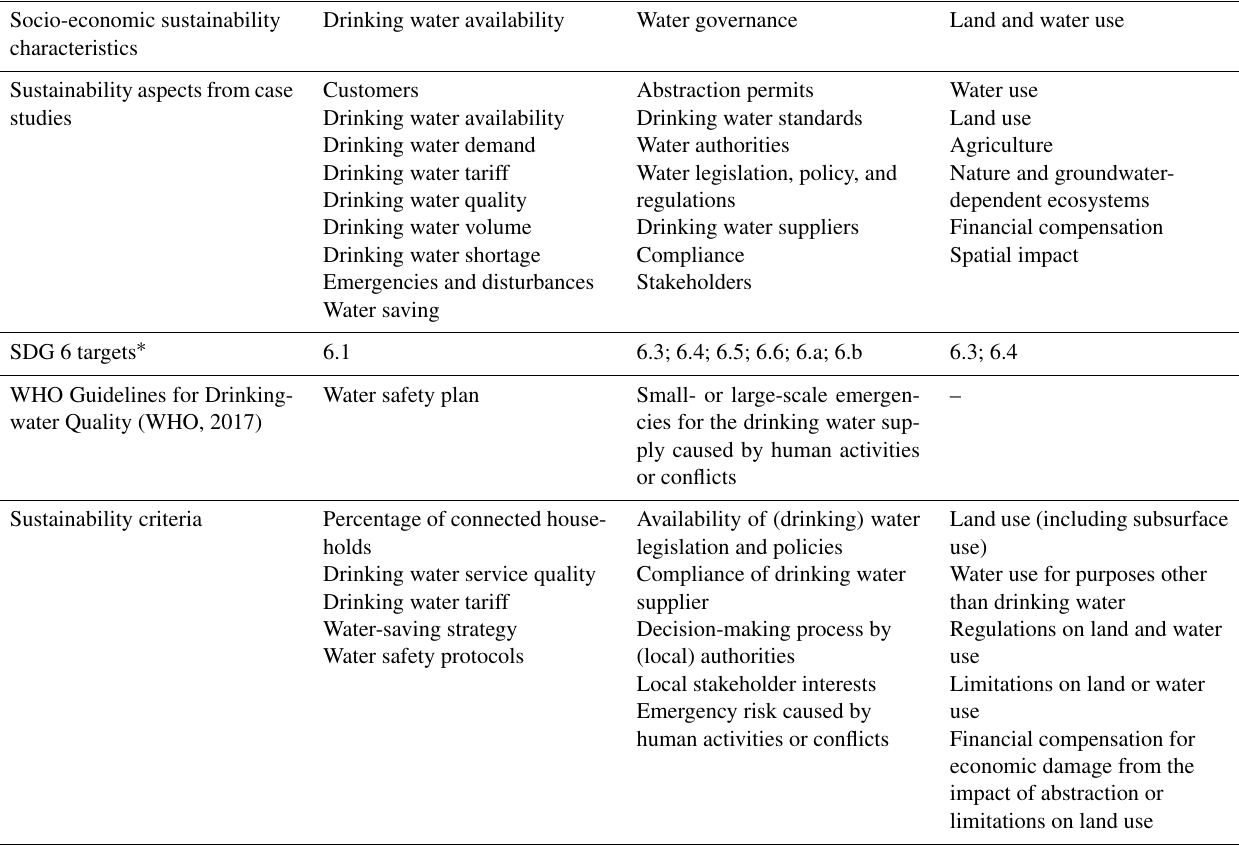
Table 3. Summary of proposed socio-economic sustainability characteristics, socio-economic aspects from case studies (see Appendices A– C), relevant SDG ∗ indicators and WHO Guidelines for Drinking-water Quality (WHO, 2017) aspects, and socio-economic sustainability